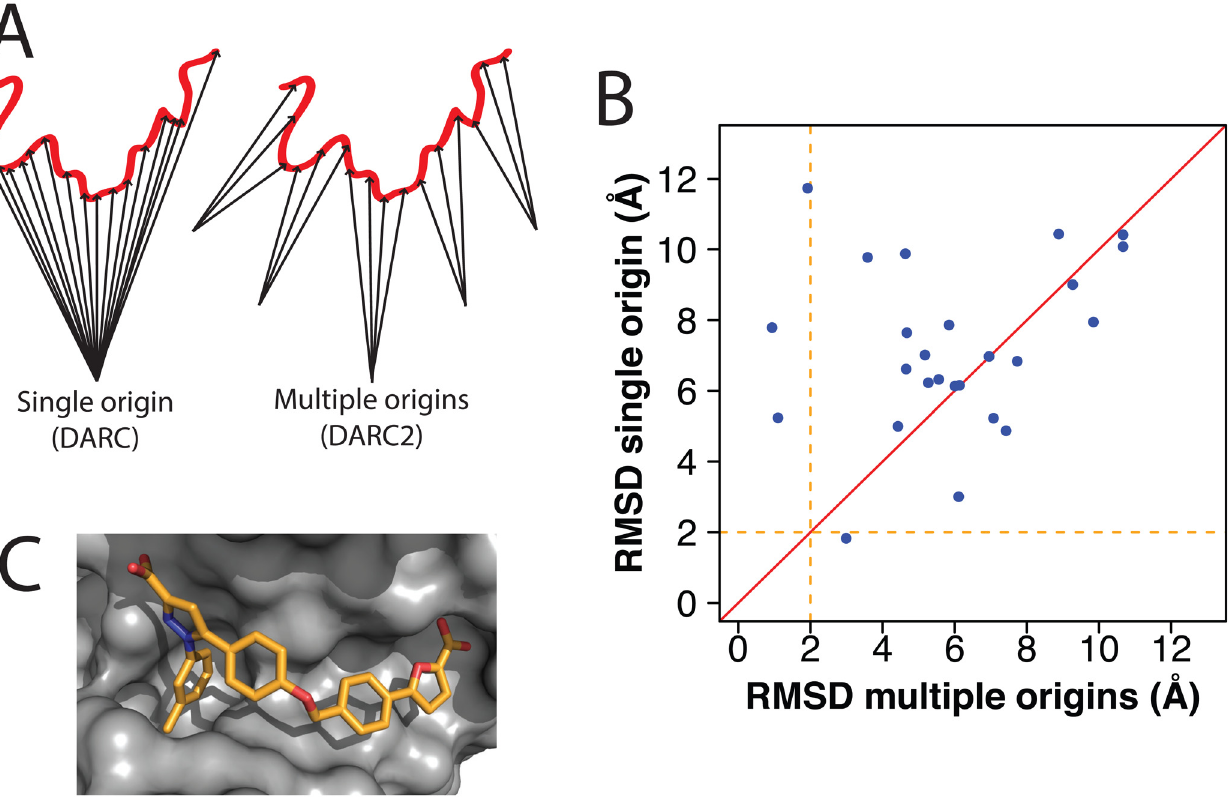
Fig 2. Ray-casting from multiple origins. (A) In DARC 2.0, rays emanate from five origin points instead of from a single origin point. This allows more of the protein surface to be “ visible ” to the rays, and in turn leads to a more complete representation of the surface topography. (B) For each protein-ligand complex in our set (S1 Table), we used DARC to dock the ligand back into its cognate receptor. Multiple ligand conformations were considered in the search, while the receptor conformation was held fixed throughout docking. The RMSD of the docked ligand was evaluated relative to its position in the crystal structure of the complex. Each point represents a separate complex; points above the diagonal are those for which the use of multiple origins led to better pose recapitulation. (C) A representative example of a complex that was better-predicted using multiple origins (PDB ID 4luz). Part of the binding pocket points directly into the protein ( left side of picture ), and thus directly at the origin (if a single origin is used). The use of multiple origins allows the “ walls ” of this region of the binding pocket to be included in the surface topography considered for docking.